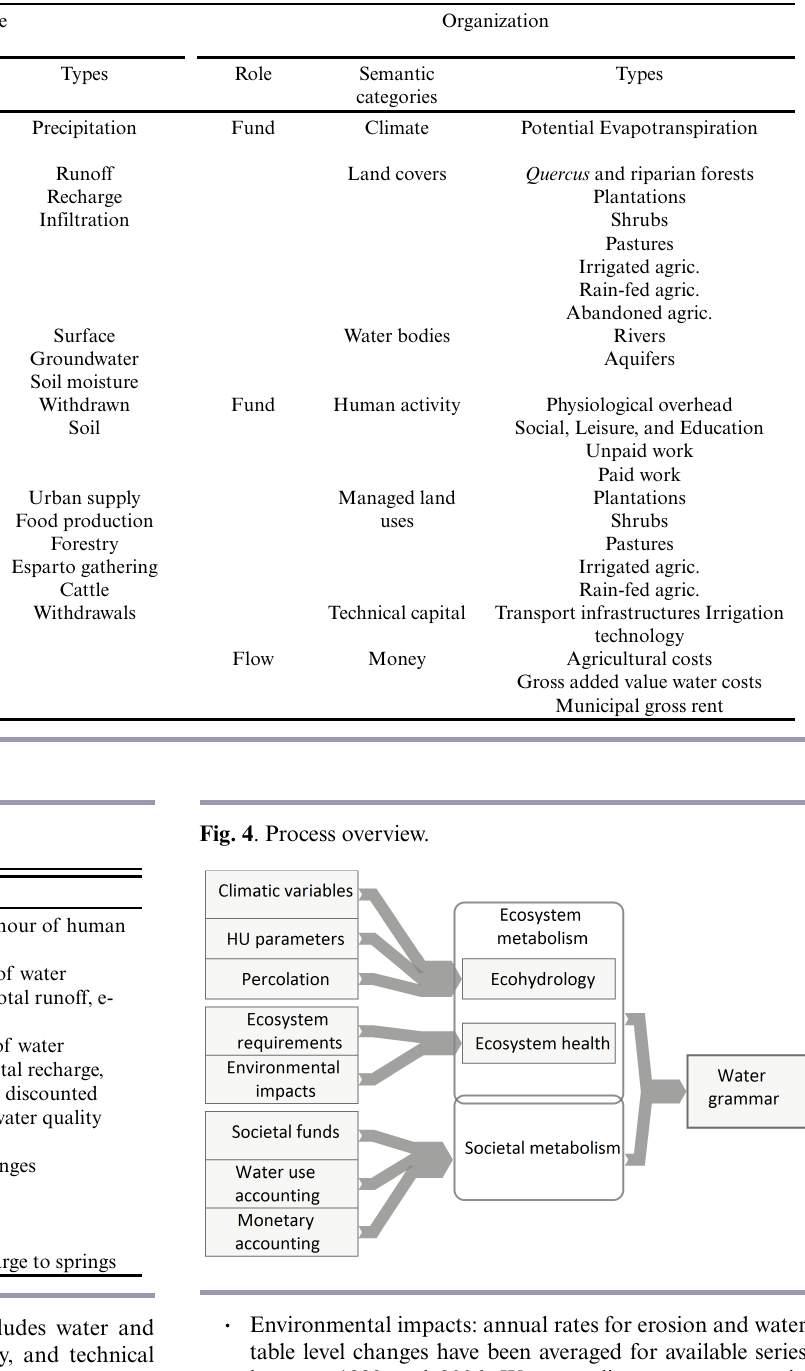
Table 3 . Water grammar for the Upper Andarax basin. Adapted from Madrid and Giampietro (2014).